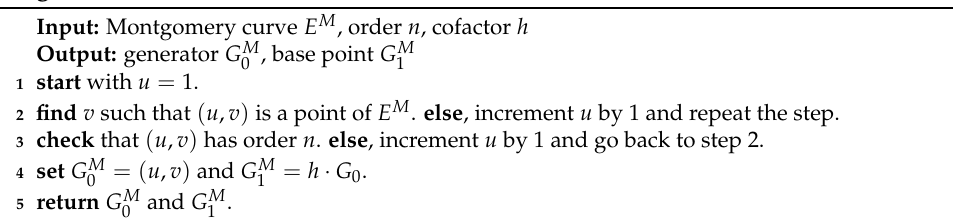
Algorithm 2: Generator and Base Points of E